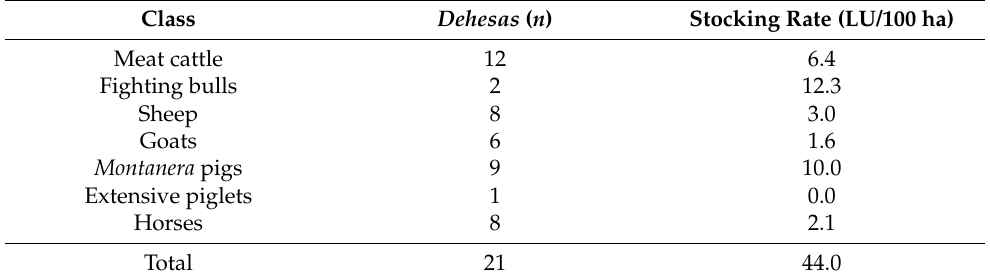
Table 1. Livestock species stocking rate for large privately owned case-study dehesas in Andalusia (2010).